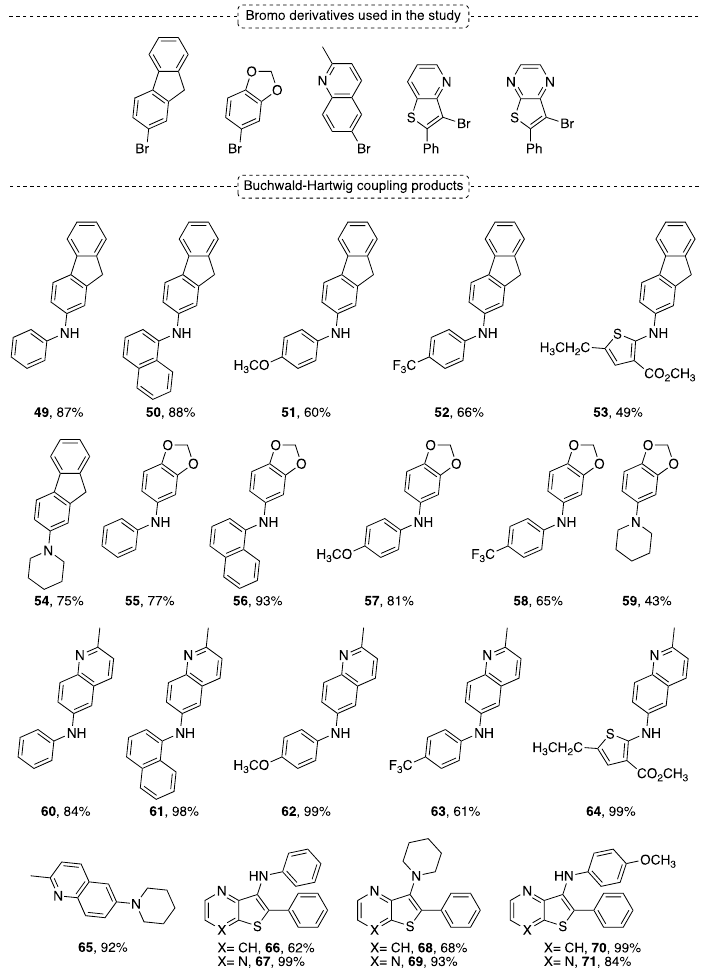
Figure 7. Buchwald – Hartwig coupling products in eucalyptol [145]. Figure 7. Buchwald–Hartwig coupling products in eucalyptol